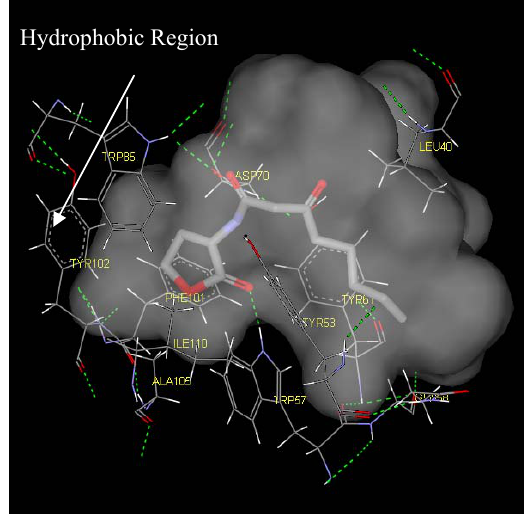
Figure 6. Binding pocket surface representation of Monomer A (TraR) with the native autoinducer (E) docked into the receptor site. The ‘transparent cloud’ indicates the binding pocket while atoms of the autoinducer are displayed as thick lines. The thin lines are representative of the different residues surrounding the active site. Green dotted line indicates